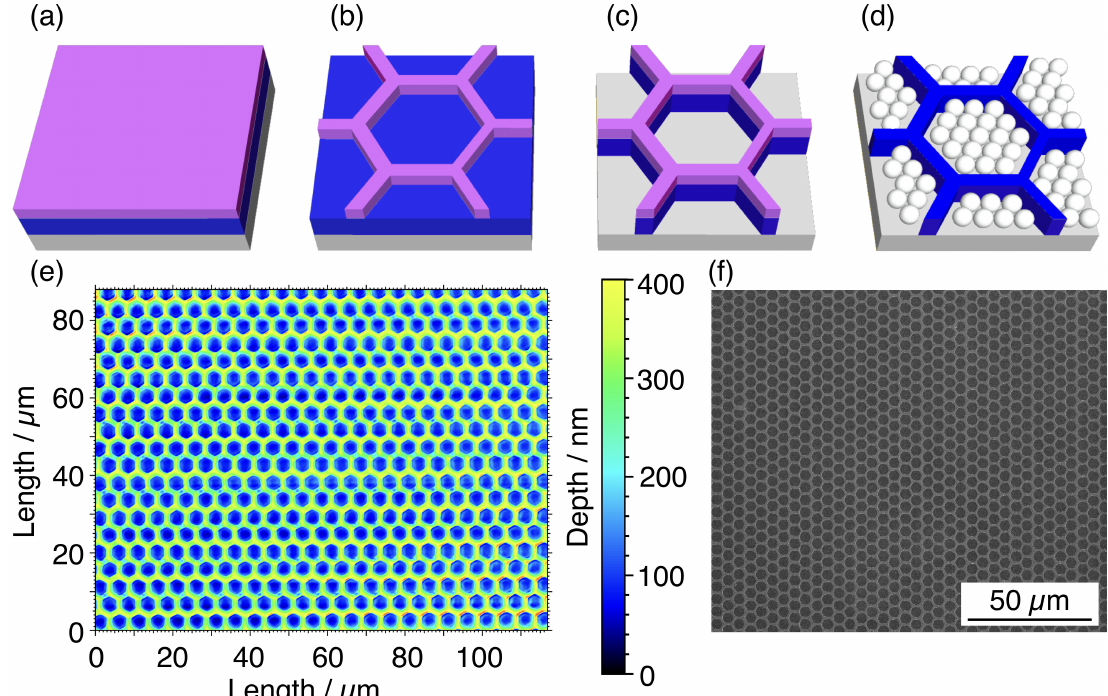
Figure 1. ( a ) The silicon (grey) substrate with a SiO 2 layer (blue) is covered with a layer of photosensitive resist (purple). ( b ) The hexagonal pattern is designed on the resist by direct laser writing (DLW) lithography and developed to expose the underlying SiO 2 layer, ( c ) which is then etched by reactive ion etching process (RIE). ( d ) The PS NSs are deposited inside the resulting template. ( e ) Optical profilometry image and ( f ) SEM micrograph at low magnification showing the hexagonal templates over large area after the